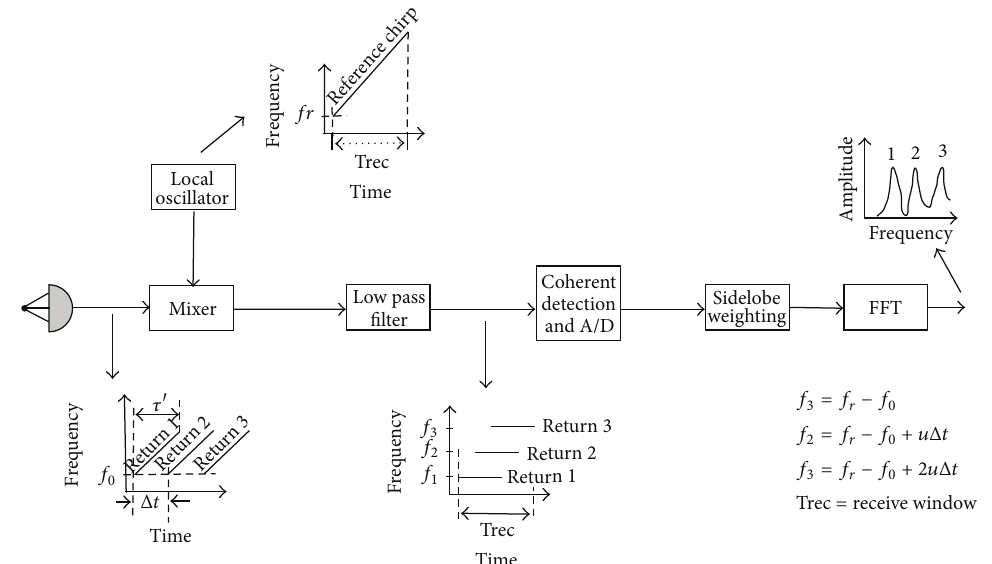
Figure 2: Block diagram of the Stretch Processor technique.